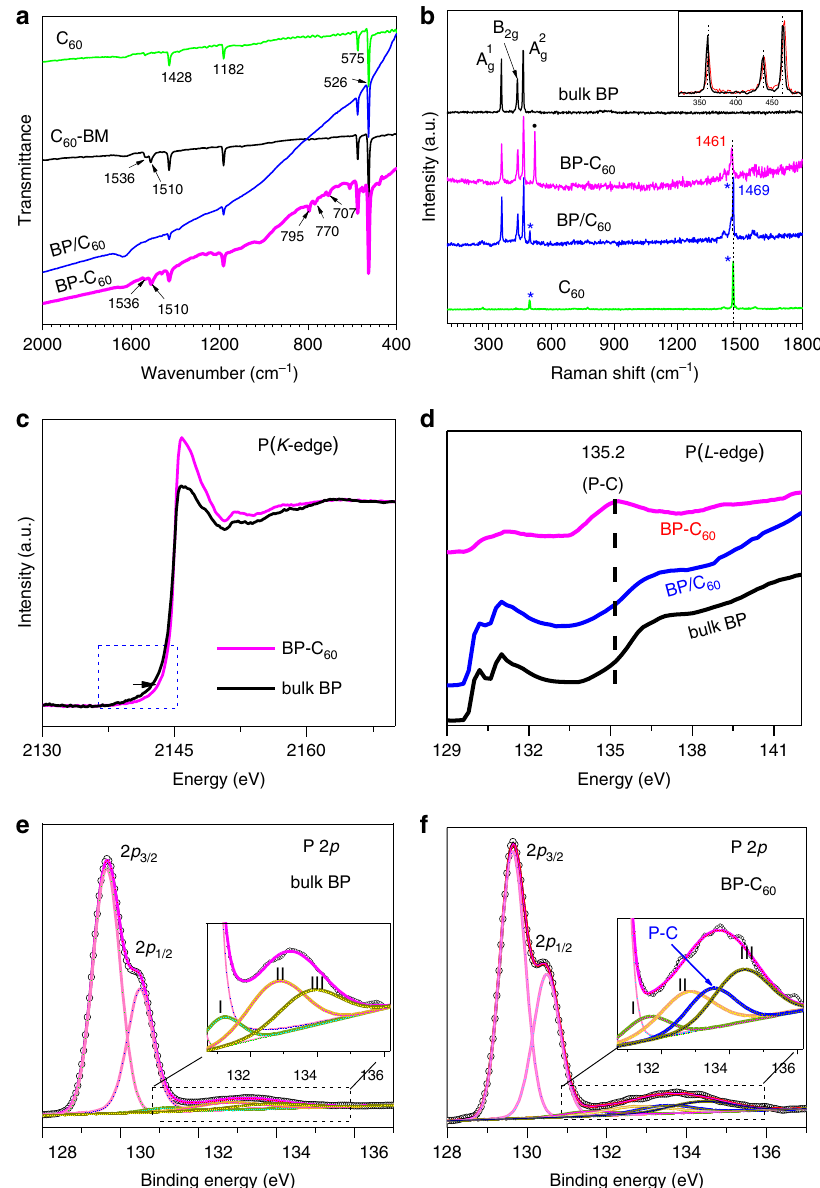
Fig. 2 Spectroscopic characterizations. a FTIR spectra of the pristine C 60 , C 60 -BM, BP/C 60 mixture and the BP-C 60 hybrid. b Raman spectra of bulk BP, the BP-C 60 hybrid, BP/C 60 mixture, and pristine C 60 . The fi lled circle marks the signal of Si substrate, and the asterisks label the signal of C 60 . Inset: enlarged spectra of bulk BP and the BP-C 60 hybrid. c P K -edge XAS spectra of bulk BP and the BP-C 60 hybrid. d P L -edge XAS spectra of bulk BP, BP/C 60 mixture and the BP-C 60 hybrid. e High-resolution P2p XPS spectra of bulk BP. f High-resolution P2p XPS spectra of the BP-C 60 hybrid. Numbers I-III label the signals assigned to P-O-P (bridging bonding), O – P = O (dangling bonding), and P 2 O 5 , respectively